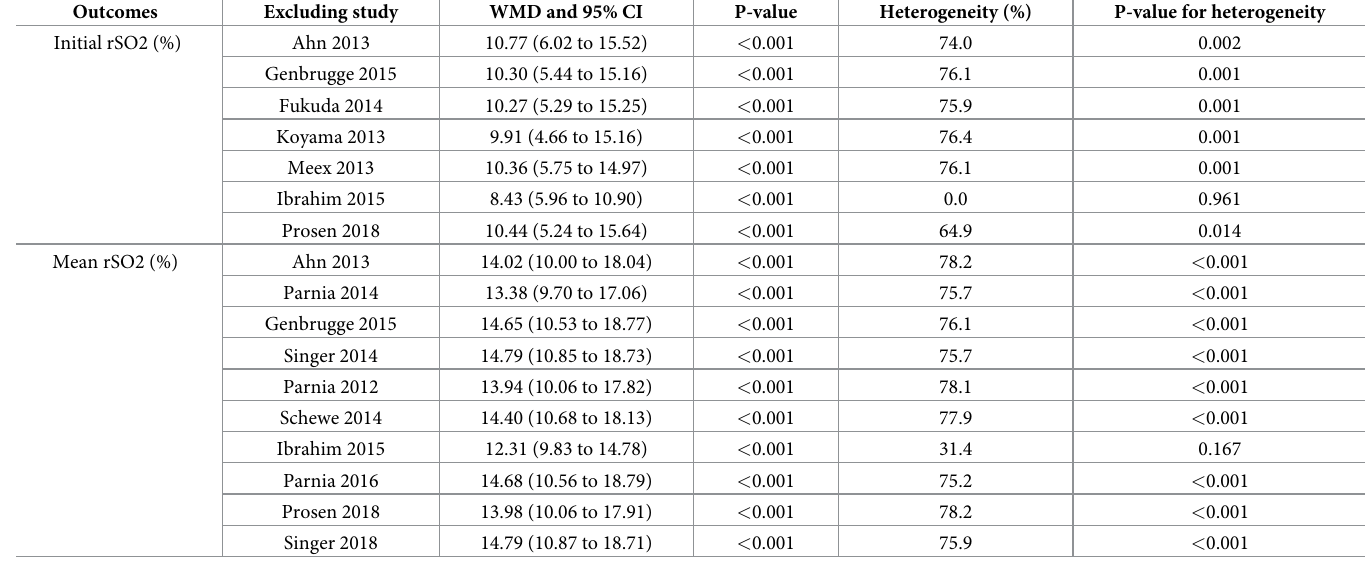
year, study design, and study quality) or patients’ (mean age, sex, and location of cardiac arrest) characteristics are yet to be elucidated. In this comprehensive quantitative meta-analy- sis, 678 CA patients from 13 studies with a broad range of characteristics were included. The summary results indicated that ROSC vs . non-ROSC was significantly associated with high Table 2. Sensitivity analyses for initial rSO2 and mean